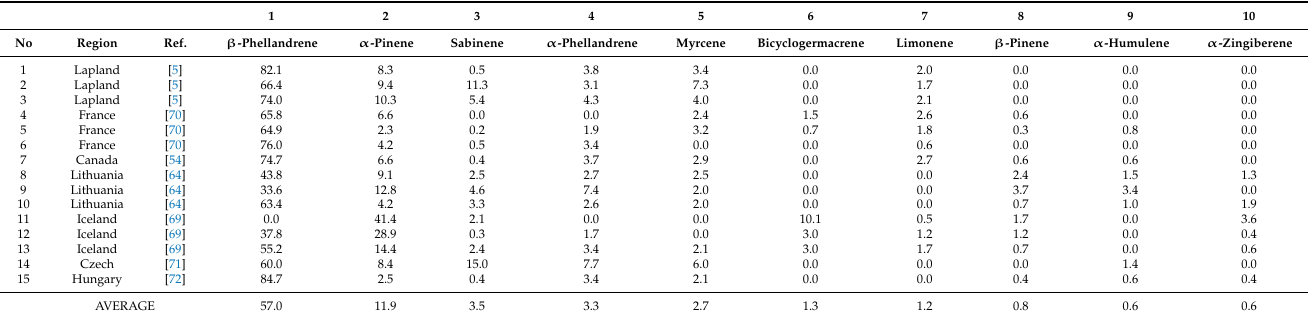
Table 2. Chemical composition of different A. archangelica seed (fruit) essential oil accessions according to the